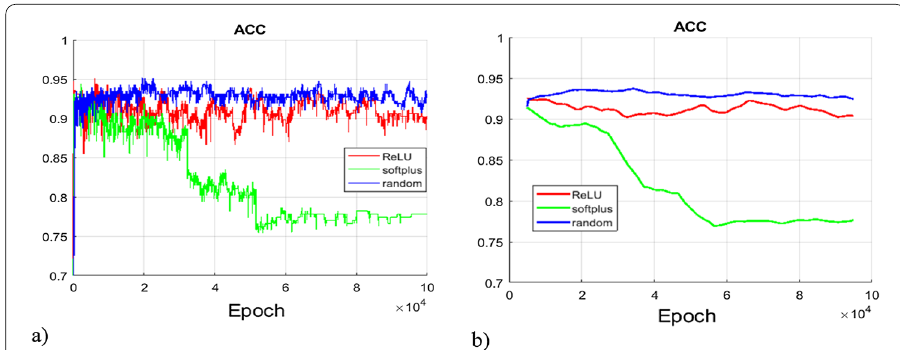
Fig. 4 The changes of testing accuracy in the following learning epochs: a temporary changes; b the smoothed moving average form. A very long learning procedure depicts a significant effect of overlearning in the case of softplus. ReLU and random structure do not experience such an overlearning